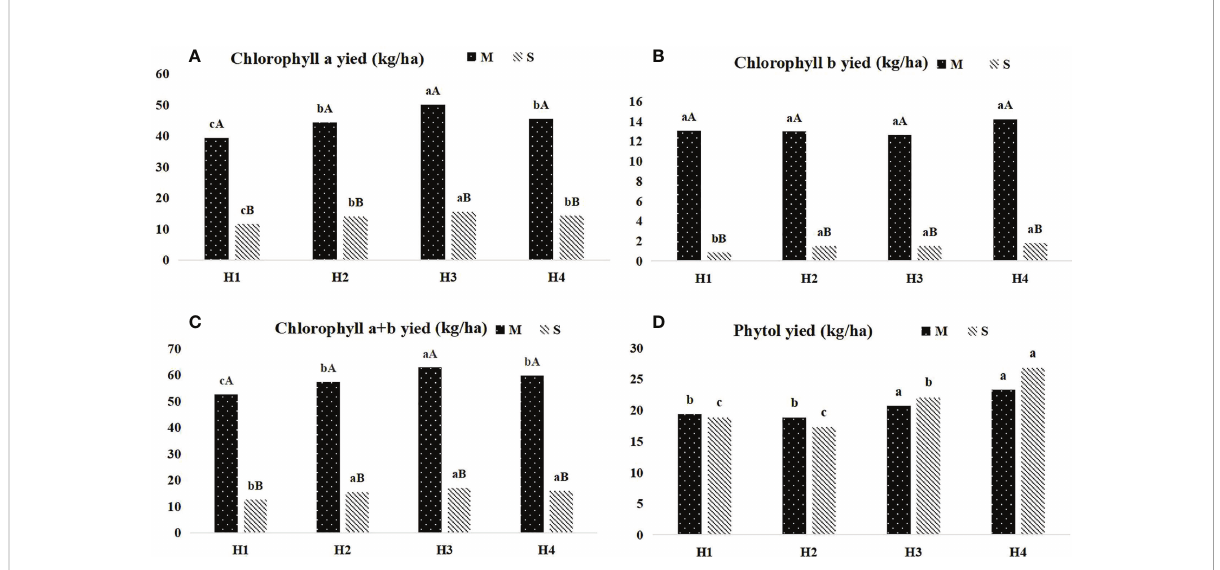
FIGURE 2 Dynamics of chlorophyll and phytol yield in different height Pennisetum sinese and silage. The yied of chlorophyll a, chlorophyll b, chlorophyll a +b and phytol (A – D) .M: Pennisetum sinese material; S: Pennisetum sinese silage. Boxes with a different letters above the error bars are signi fi cantly different between different height (a – c) or material and silage (A, B) at P < 0.05.